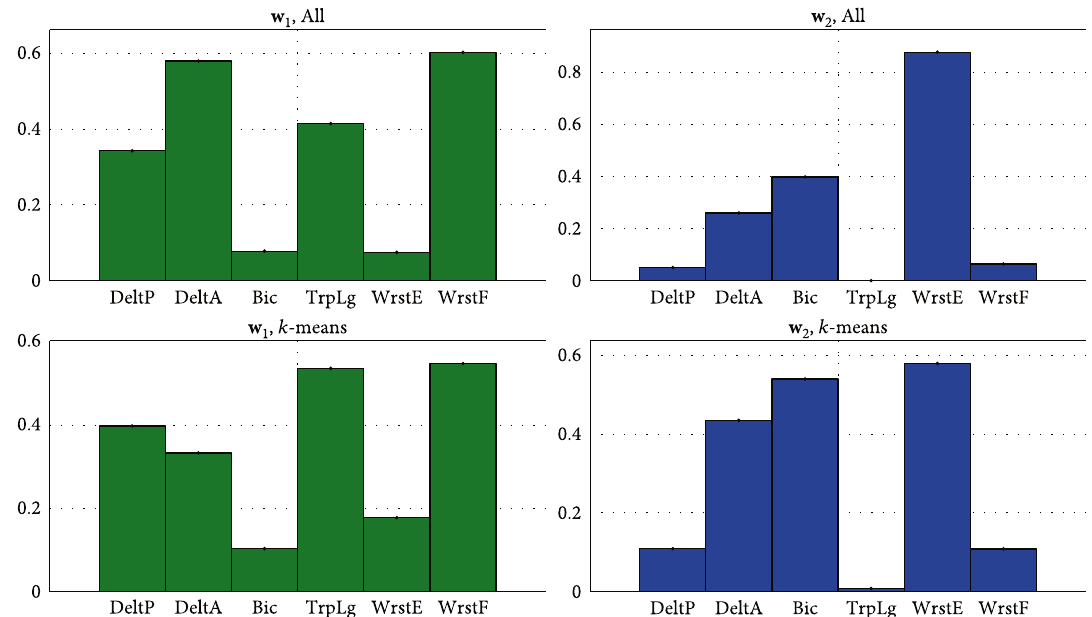
W I,All and II,All for all subjects. A common control representation in the